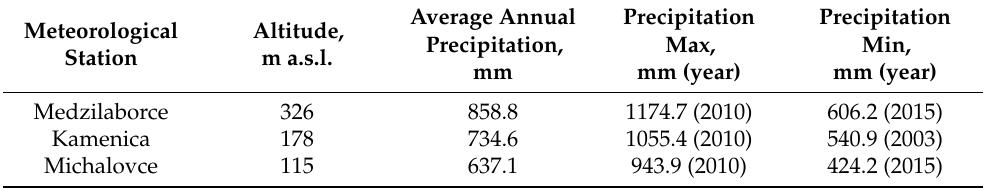
Table 2. Average annual precipitation totals in